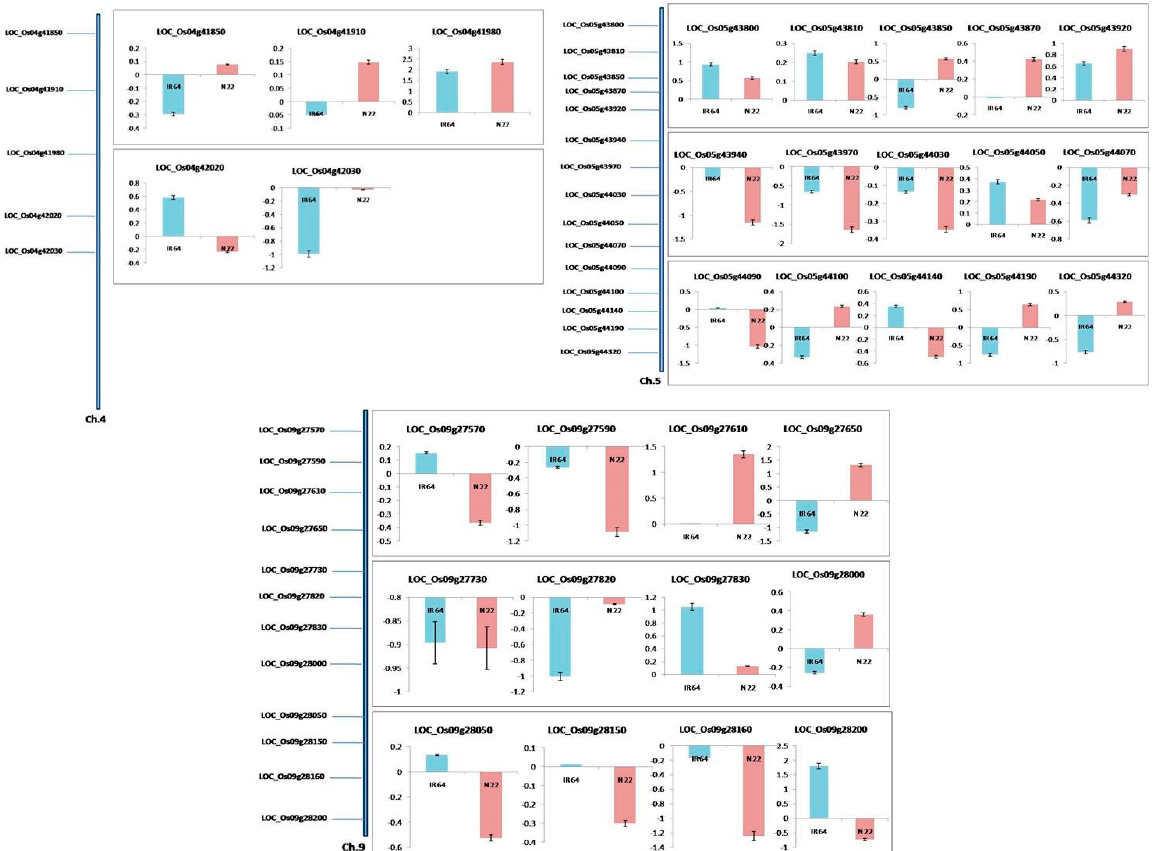
Figure 6. Expression profiling of the genes present in the selected QTLs regions which have single nucleotide polymorphism(s) in the parental genotypes, N22 and IR64, under eight days of heat stress by qPCR. The genes from the three QTL regions are shown in separate panels. The Y axis in all the graphs represents fold change in expression with respect to control (optimal temperature) conditions.